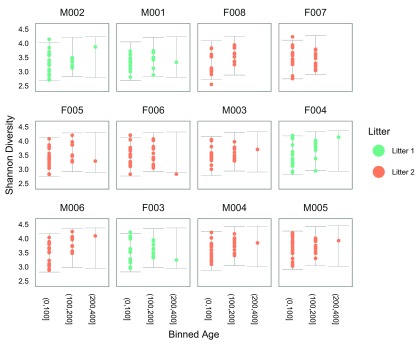
Each point represents the Shannon diversity at one timepoint for a mouse; each panel is a different mouse.The timepoints have been split into three bins, according to the mices’ age. The prediction intervals obtained from mixed-effects modeling are overlaid.